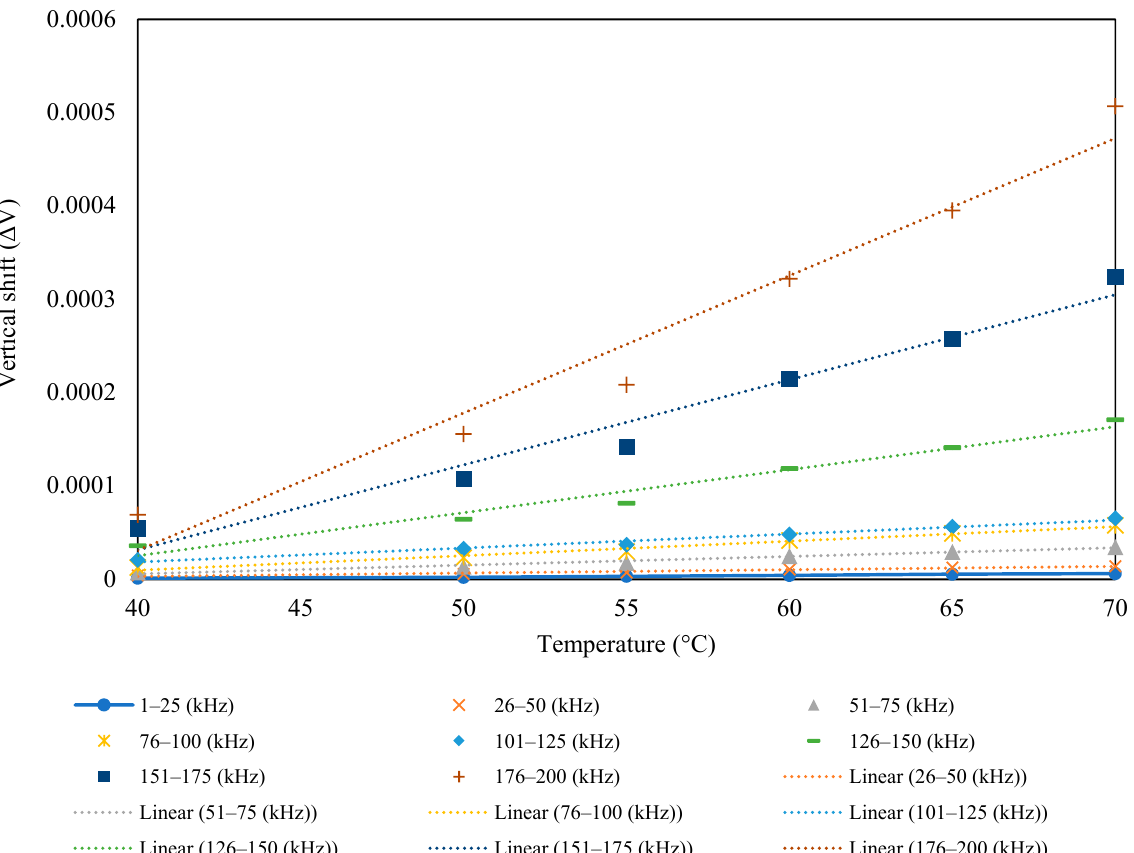
Figure 5. Horizontal shift as a function of temperature.